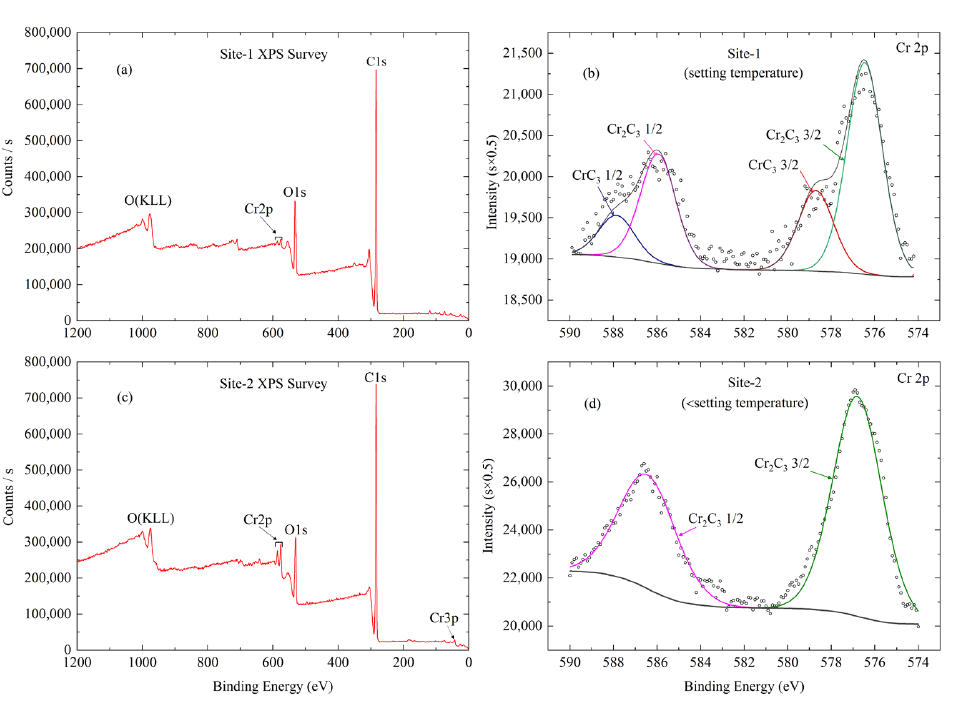
Figure 4. XPS surveys ( a , c ) and Cr 2p spectra ( b , d ) of specimens at sites 1 and 2.